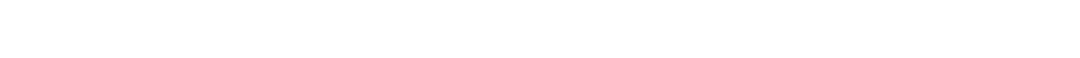
FIGURE 3 |There is a linear relationship between clinical rigidity scores and damping ratio (robustfit, p = 0.0144) .This relationship could be utilized to predict rigidity scores, which significantly correlate with actual recorded rigidity